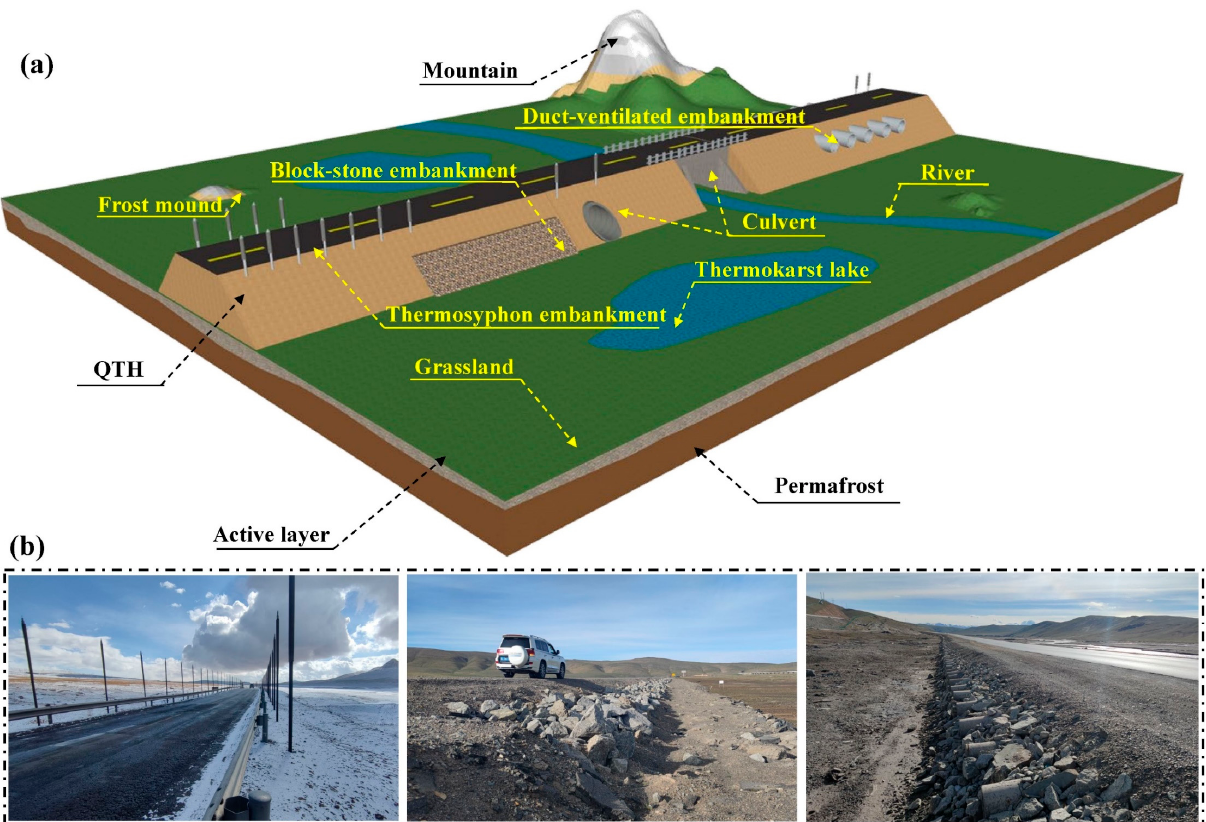
Figure 1. ( a ) Proactive temperature-controlling measures and the surrounding environment along the QTH; ( b ) field photographs, from left to right: thermosyphon embankment; block-stone embankment, and duct-ventilated